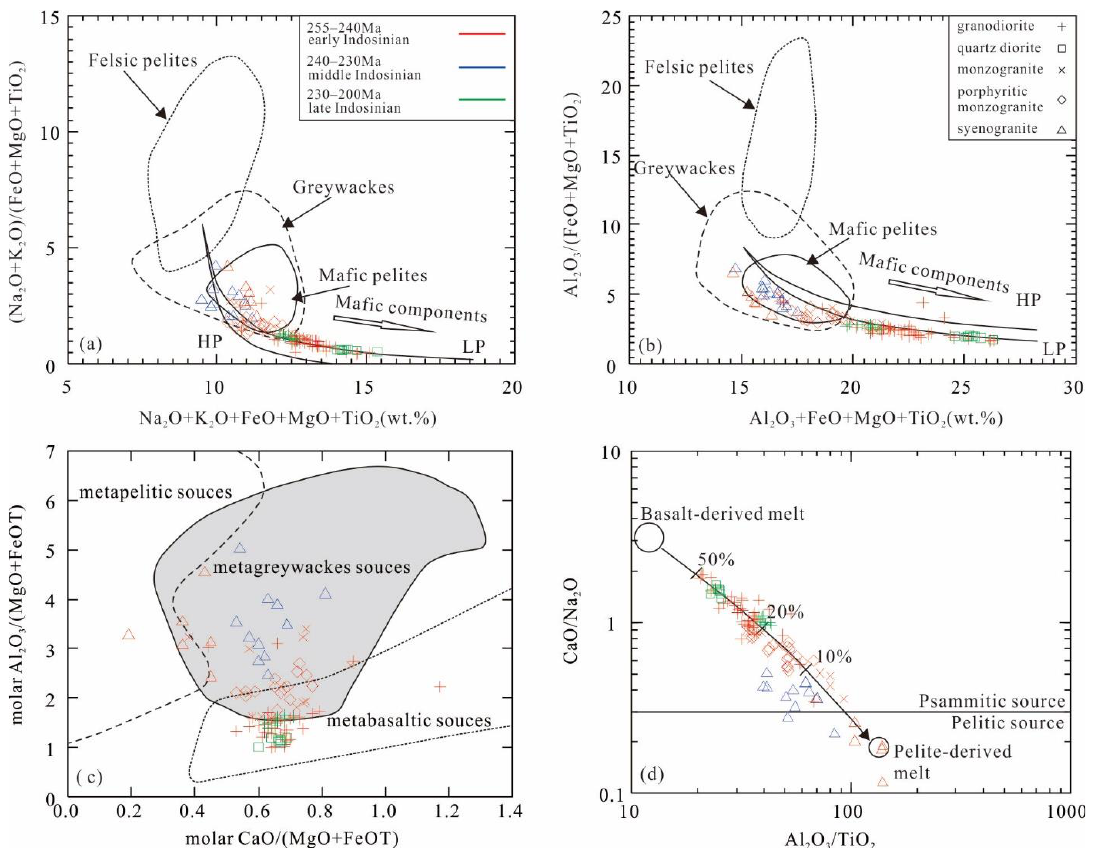
Figure 7. Diagrams of ( a ) Na 2 O + K 2 O + FeO + MgO + TiO 2 vs. (Na 2 O + K 2 O)/(FeO + MgO + TiO 2 ) (after [57]); ( b ) Al 2 O 3 + FeO + MgO + TiO 2 vs. Al 2 O 3 /(FeO + MgO + TiO 2 ) (after [57]); ( c ) molar CaO/(MgO + FeO T ) vs. molar Al 2 O 3 /(MgO + FeO) (after [58]); and ( d ) Al 2 O 3 /TiO 2 vs. CaO/Na 2 O (after [52]) for the Indosinian granite in the eastern region of the EKO.